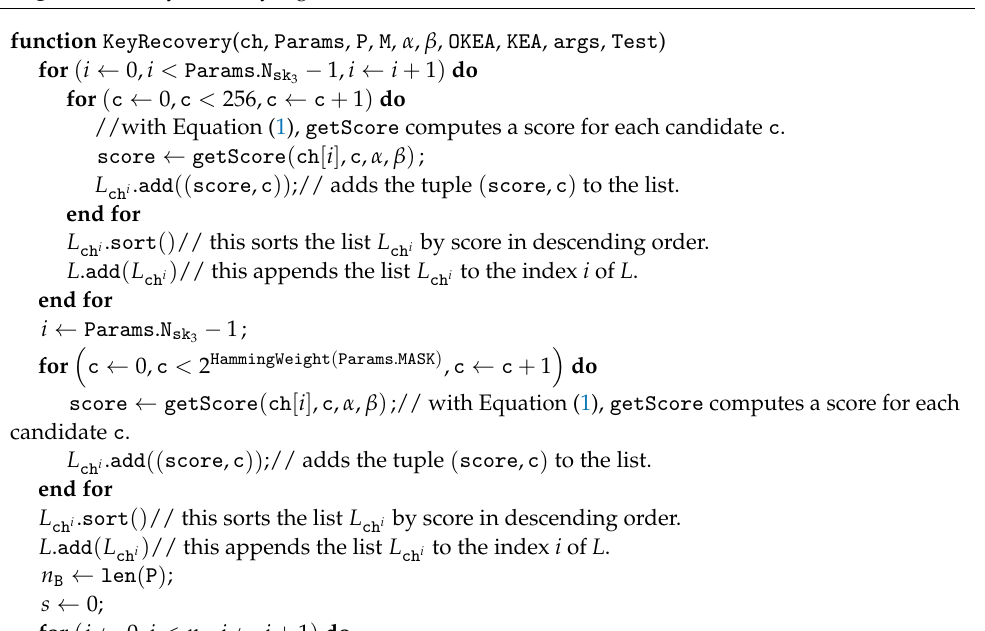
Algorithm 4 Key-recovery algorithm.